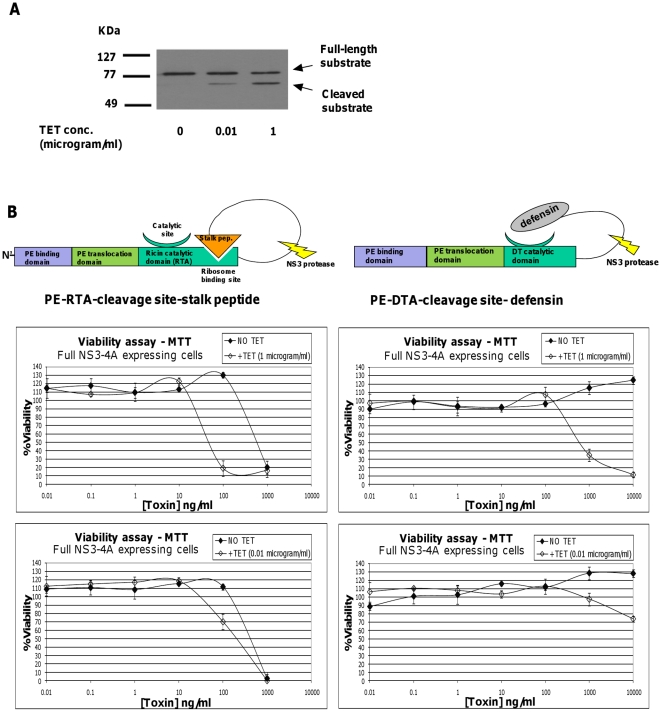
Tetracycline dose-dependence of substrate cleavage efficiency and of zymoxin-treated NS3 expressing cells viability.(A). In vivo substrate cleavage efficiency analysis: T-Rex cells inducibly expressing full NS3-4A were transfected with 2µg of the vector “pCMV/MBP-EGFP-NS5AB-CBD”. After 24 hours, cells were treated with 1µg/ml of tetracycline, 0.01µg/ml of tetracycline or left untreated. 24 hours later, cells were lysed and samples of 6µg protein from total cell extract where analyzed by immunoblotting with mouse-serum anti-MBP followed by HRP-conjugated secondary antibodies and ECL development. (B). Viability assay: T-Rex cells inducibly expressing full NS3-4A were seeded (2×104 cells per well) in 96-well plates. After 24 hours, cells were supplemented with 1µg/ml of tetracycline (+TET (1 microgram/ml)), 0.01µg/ml of tetracycline (+TET (0.01microgram/ml)) or left untreated (NO TET). Eight hours later, cells were incubated for 72 hours with serial dilutions of the toxins “PE-DTA-cleavage site-defensin” or “PE-RTA- cleavage site-stalk peptide” (toxins were diluted in growth media supplemented with the appropriate tetracycline concentration. presence of tetracycline was kept in the growth media of induced cells). The relative fraction of viable cells was determined using an enzymatic MTT assay. Each point represents the mean ±SD of a set of data determined in triplicates.